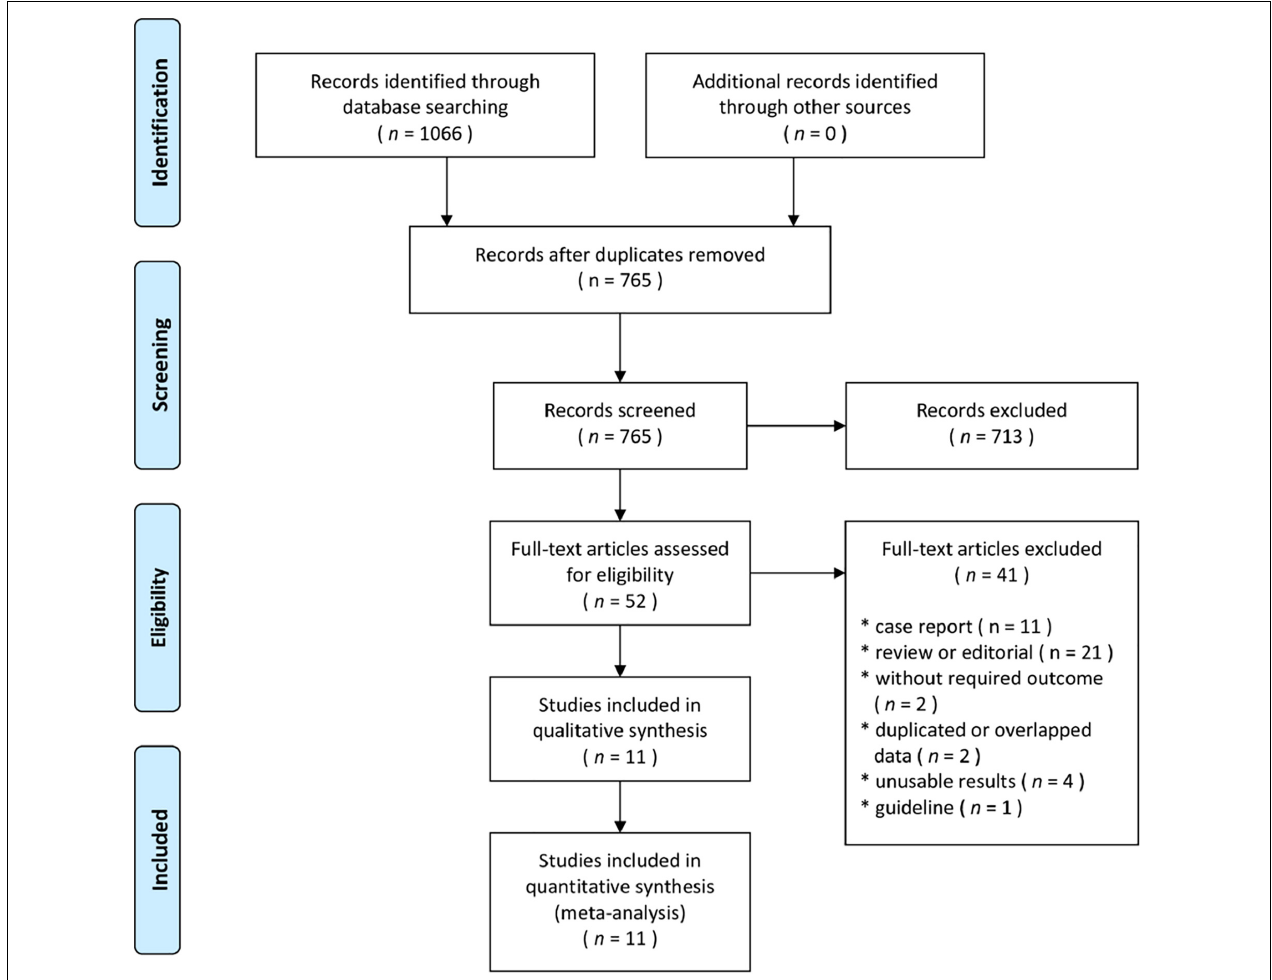
FIGURE 1 | Flow diagram showing the stages of database searching and study selection according to the PRISMA